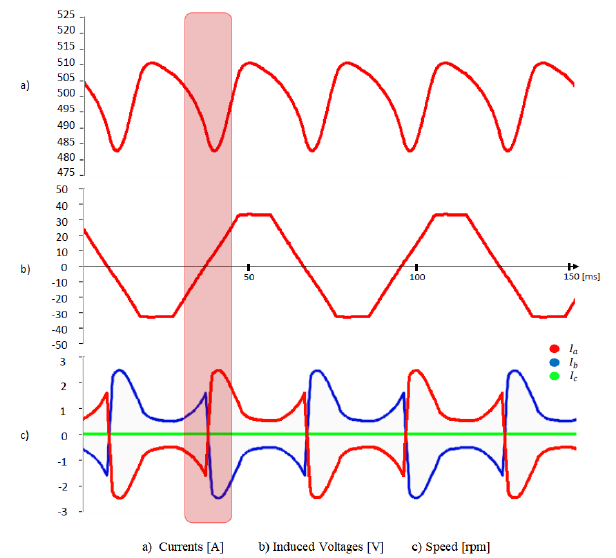
Figure 4. Waveforms of induced voltages, currents, torque and current observed by the controller of a BLDC motor with faut in phase c in 180° Six-Step operation mode. Table 2. Motor Parameters.